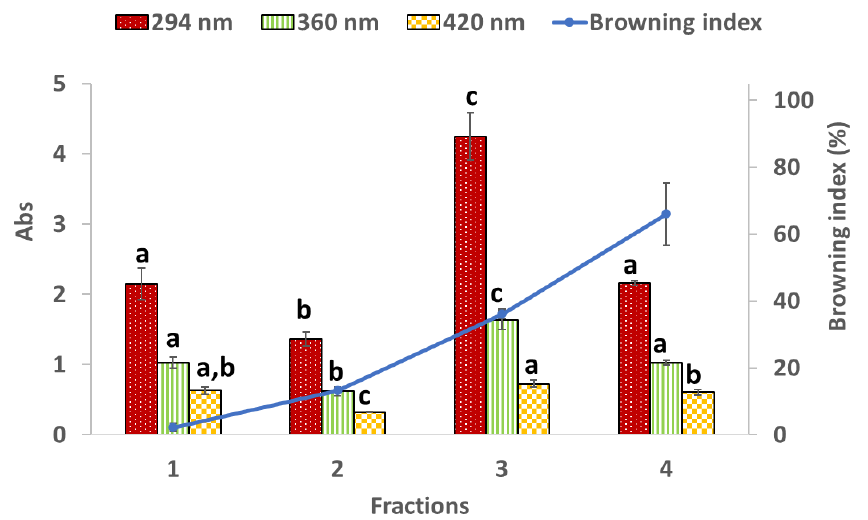
Figure 1. Maillard reaction products and browning index for Himanthalia elongata (L.) S.F.Gray. Results are expressed as mean ± SD of three experiments ( n = 3). For each wavelength, different superscript letters mean statistically significant differences ( p < 0.05).